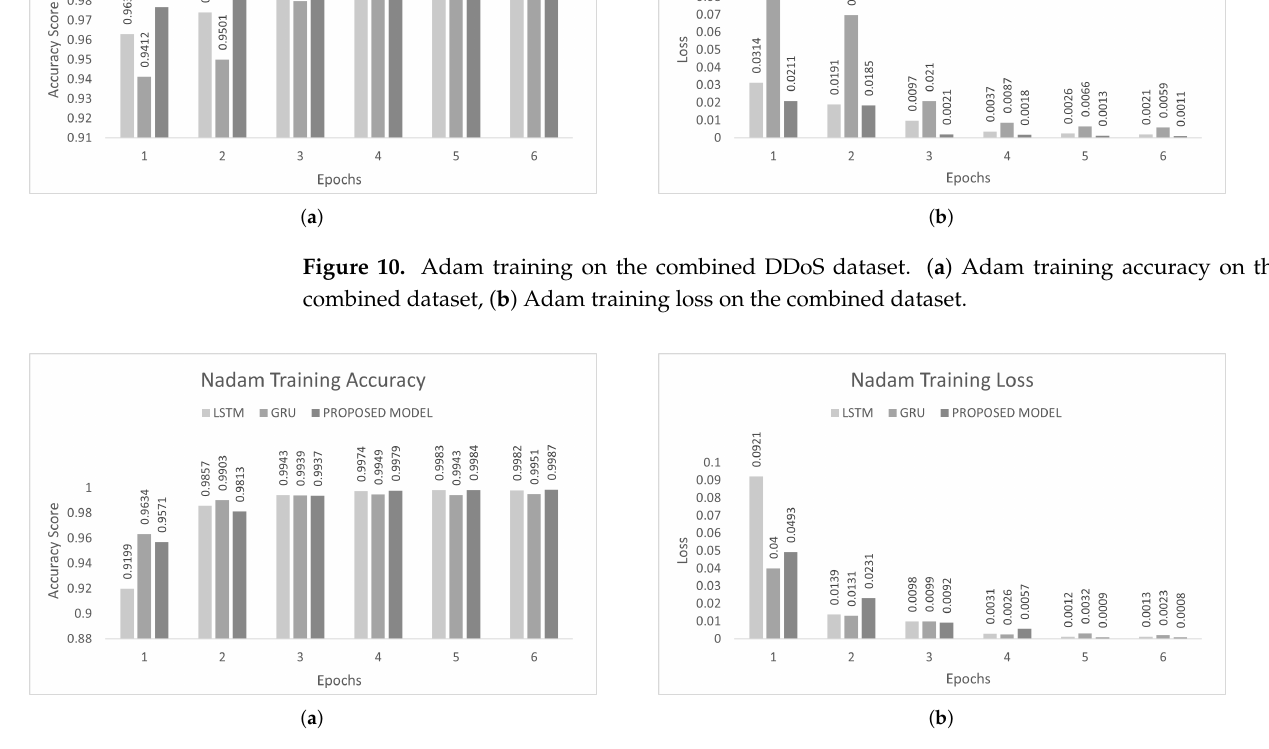
Figure 11. Nadam Training on Combined DDoS dataset. ( a ) Nadam Training Accuracy on Combined dataset, ( b ) Nadam Training Loss on Combined dataset.